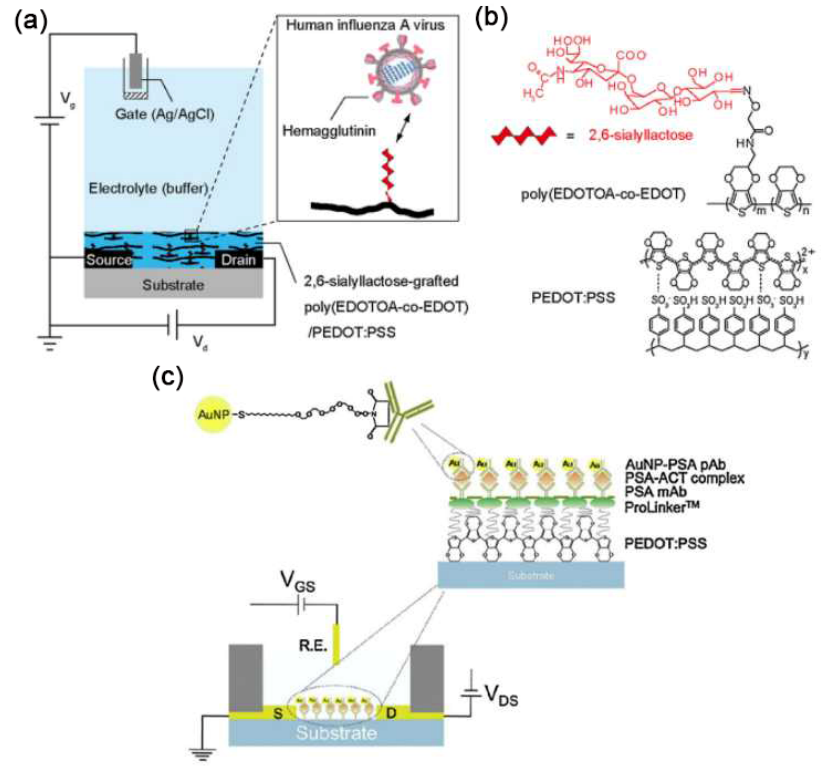
Figure 4. Schematic illustration of functionalization of PEDOT:PSS channel for the detection of ( a , b ) human influenza A virus and ( c ) prostate specific antigen. Figure reproduced with permission from references [39,40].